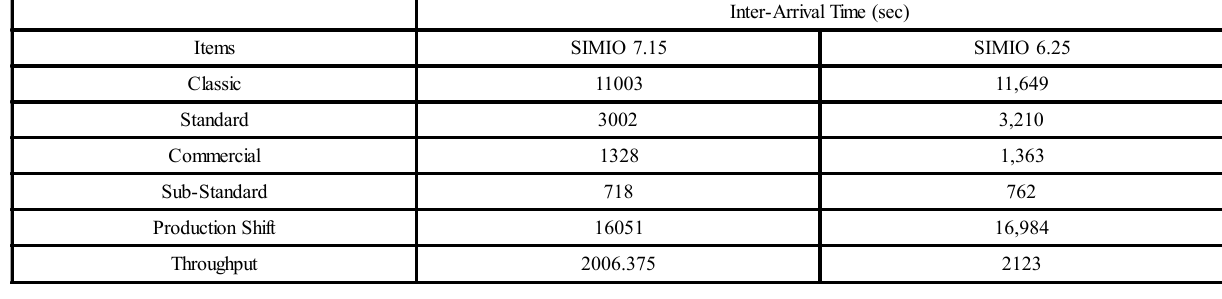
FIG. 9. CYCLE TIME VS. WORK IN PROCESS TABLE 12. RESULTS OF INTER ARRIVAL